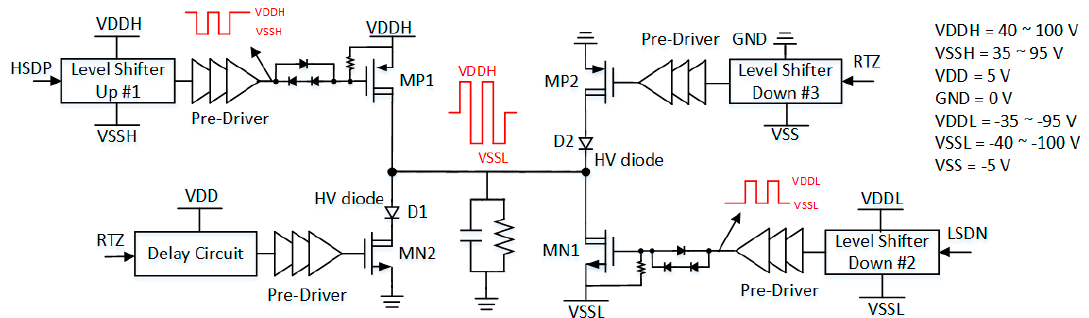
Figure 7. The H-bridge power driver and its slew-rate controller.